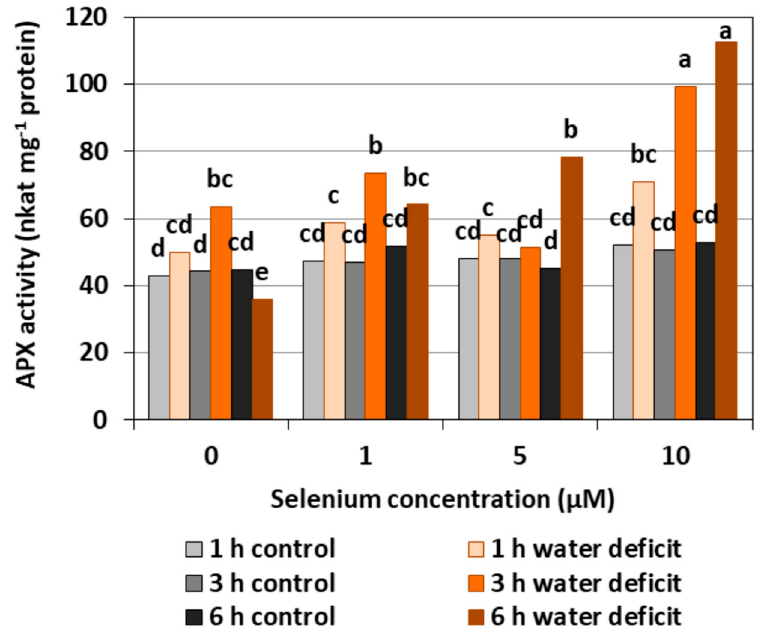
Figure 4. The ascorbate peroxidase (APX) activity in roots of cucumber seedlings pre-treated with Se and subjected to a WD. Bars marked with the same letters do not differ significantly at p < 0.05.